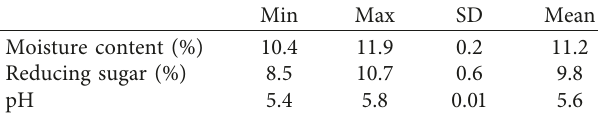
Table 3: Characters of industrial